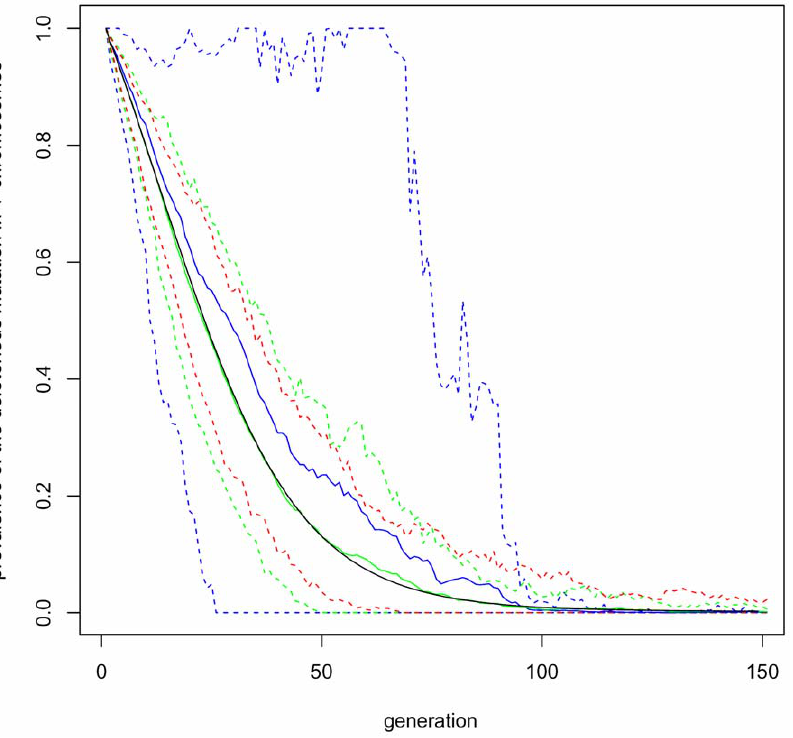
Figure 4. Drift effects under fecundity selection. This figure illustrates drift effects in populations undergoing fecundity selection (Option b. in the main matter), presenting the prevalence of the deleterious mutation in Y chromosomes. The black line represents the theoretical value of this prevalence, calculated by applying Equation 3 iteratively. The colored lines illustrate the distribution of this statistic in small populations ( n 0 ~ 200 blue, n 0 ~ 1,000 green, and n 0 ~ 5,000 red). The dashed lines indicate the 0.05 and 0.95 quantiles of these distributions. The solid colored lines indicate the sample mean for n 0 ~ 200 and n 0 ~ 1,000 . (This has been omitted for red, i.e n 0 ~ 5,000 , because it is so near to the expectation.) For each n 0 , 150 Monte Carlo replicates have been generated. The rate of sex reversal is r ~ 0 : 1 , and the other parameter values are as in ‘Baseline’, Table 1.